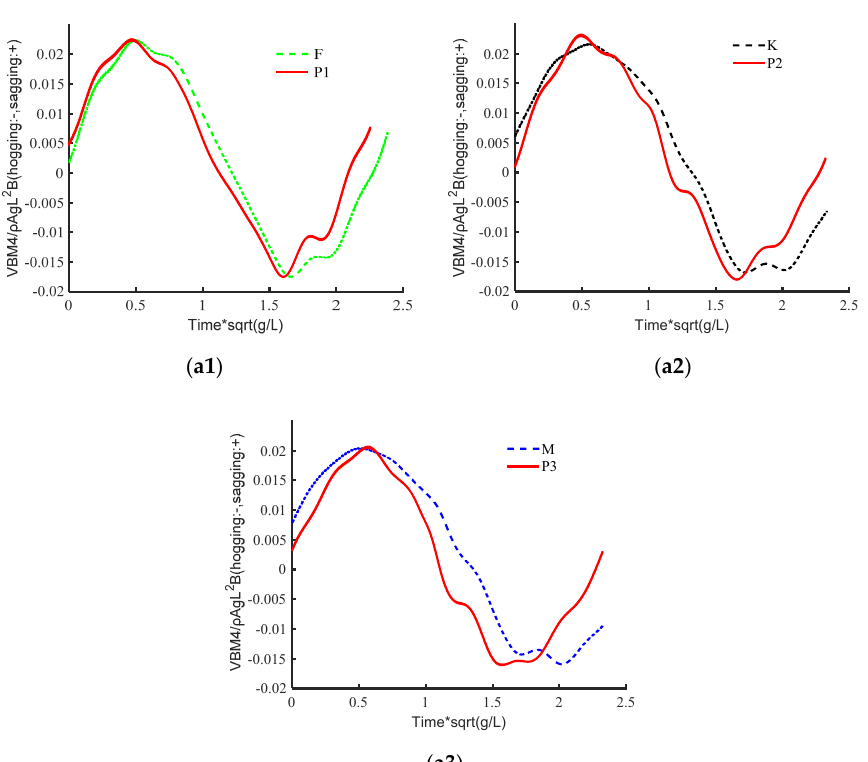
Figure 13. Effects of ship’s speed on hydroelastic response with different λ /L. ( a1 ) time series of VBM4 with λ /L=0.857; ( a2 ) time series of VBM4 with λ /L=1.07; ( a3 ) time series of VBM4 with λ /L=1.228.